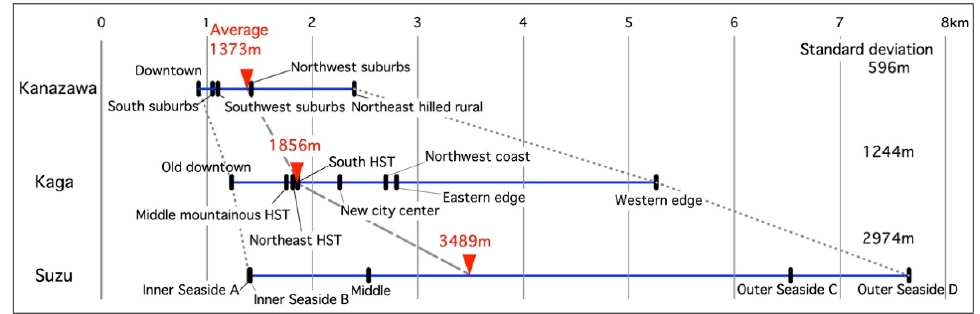
Figure 7. Distribution of proportion-weighted average of SOSLDs in each district of three target cities (unit: kilometers).